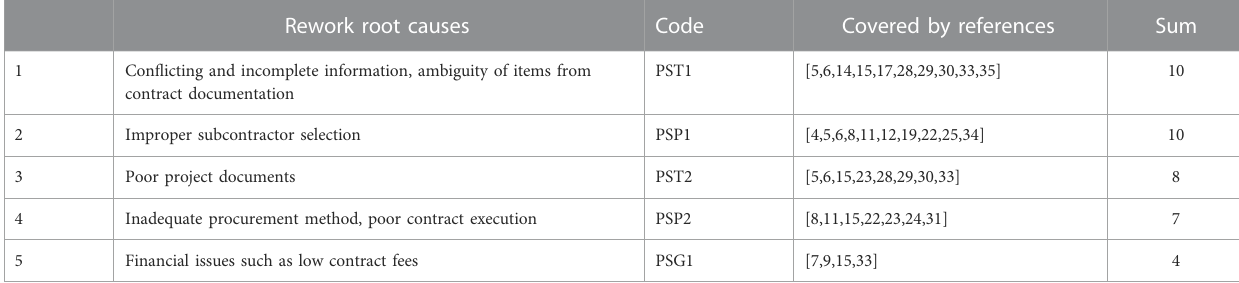
TABLE 5 Rework causes classi fi cation in procurement stage — liable to the contractor-side of the contract. Rework root causes Code